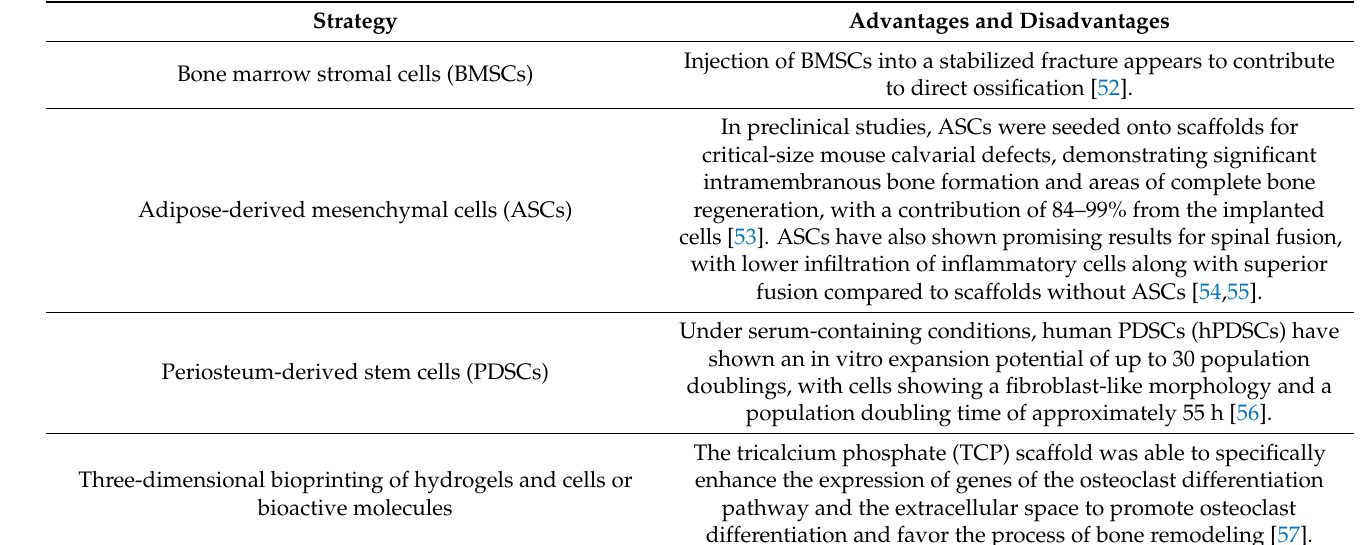
Table 3. Strategies to heal bone defects using BGS and stem cells (cell-based constructs). Strategy Advantages and Disadvantages Injection of BMSCs into a stabilized fracture appears to Bone marrow stromal cells (BMSCs)